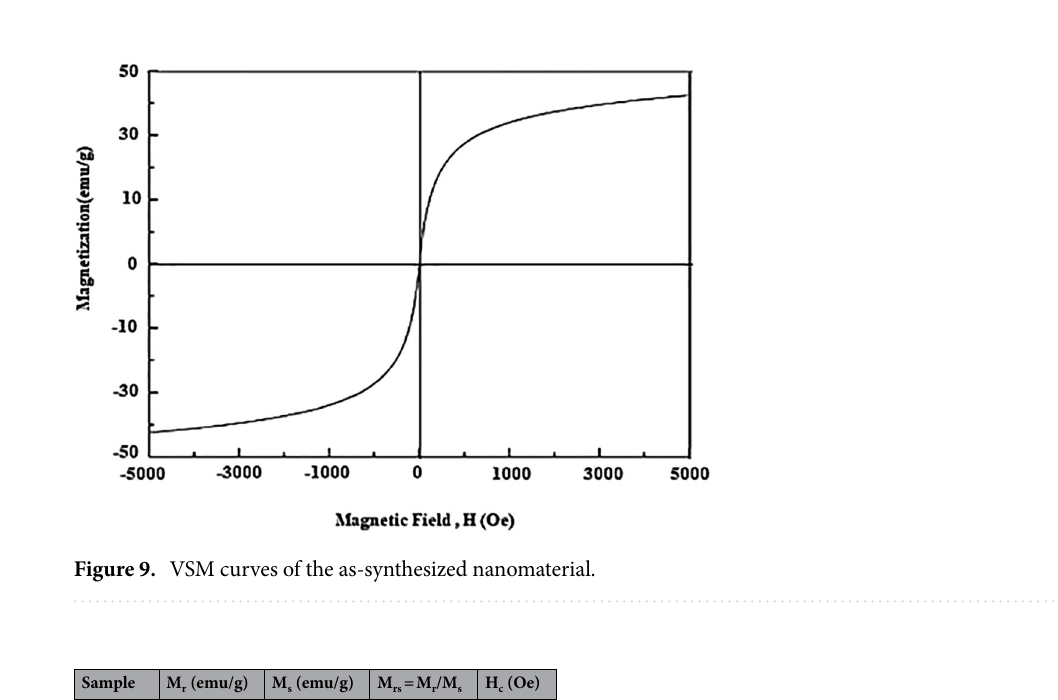
Figure 8. FESEM ( a ) and TEM ( b ) image of synthesized Cr 2 O 3 .